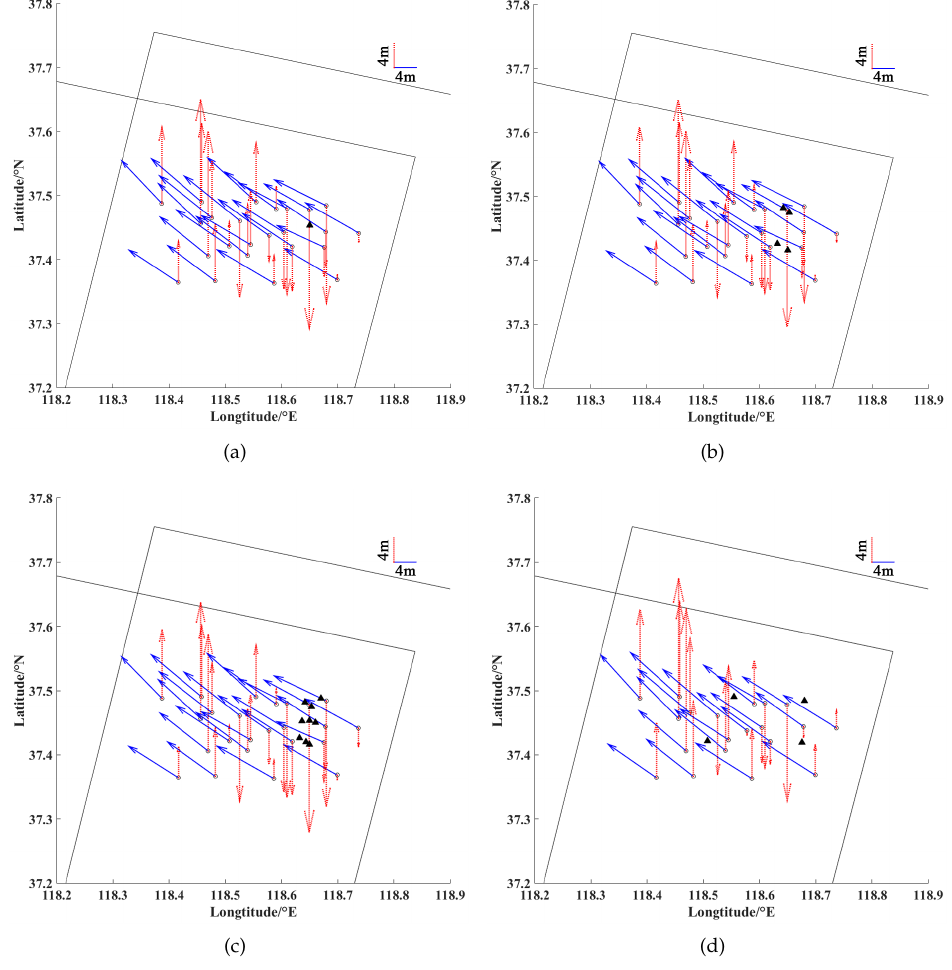
Figure 11. Geometric accuracy analysis of GF6 and GLAS combined geopositioning: ( a ) with one GLAS footprint, ( b ) with four GLAS footprints, ( c ) with nine GLAS footprints, and ( d ) with four height control